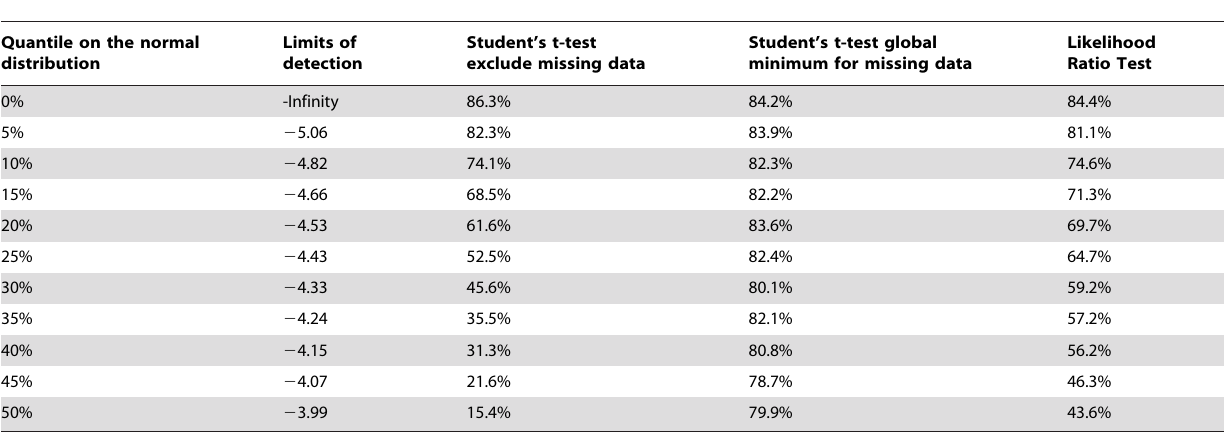
Table 3. Results for fixed difference in mean expression intensities and varying limits of detection.